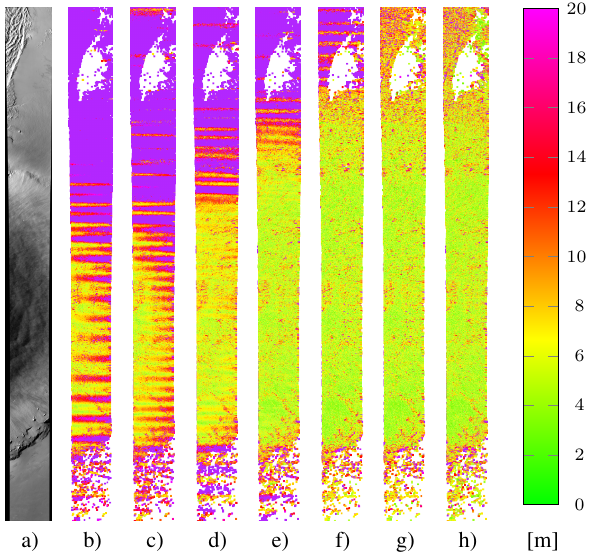
Figure 2: Forward intersection error [m] of HRSC object points with oscillation effects reduced via bundle adjustment